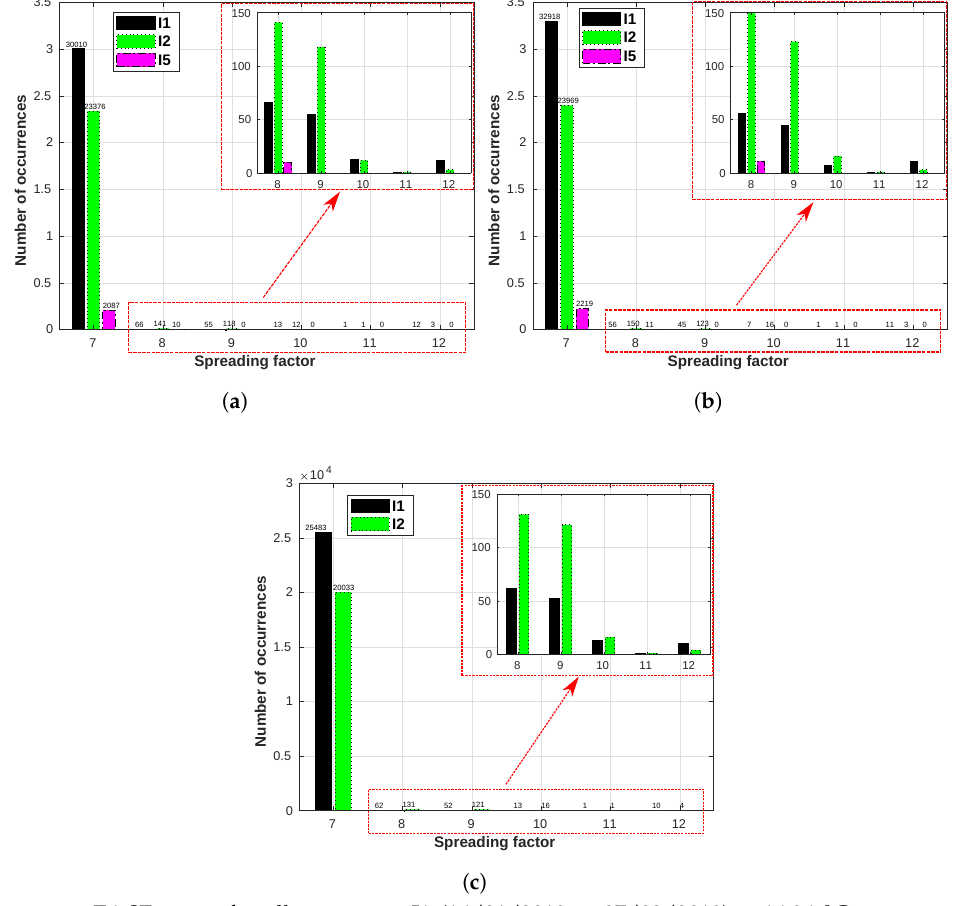
Figure 18. E6 SF usage for all gateways: I1 (16/01/2019 to 07/02/2019): − 16.96 ◦ C on average; I2 (22/12/2018 to 06/01/2019): − 9.45 ◦ C on average; I5 (15/05/2019 to 22/05/2019): 13.22 ◦ C on average. ( a ) E6 SF usage for GW1. ( b ) E6 SF usage for GW2. ( c ) E6 SF usage for